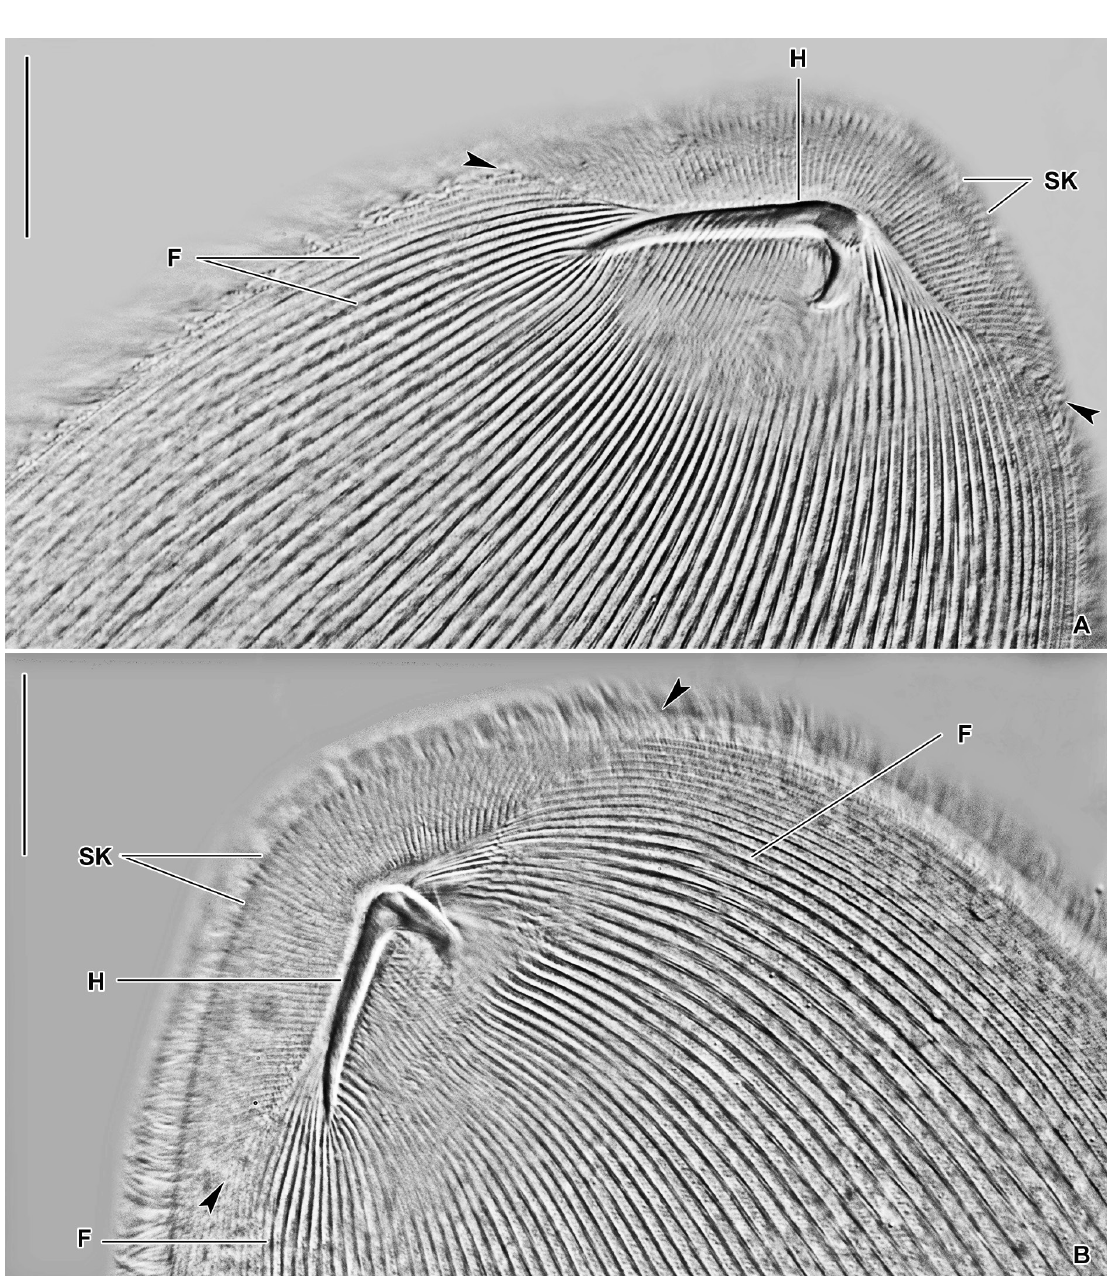
Fig. 5. A–B . Metaradiophrya lumbrici (Dujardin, 1841), Slovak specimens in vivo . Details of the anterior body portion, showing the fibrillar hook and its associated fibers. There are on average 6 (5‒7) fibers attached to the upper right side of the longer arm, on average 33 (30‒37) fibers to the ventral side of the longer arm and on average 11 (8‒13) fibers to the left side of the shorter arm. Arrowheads mark the subapical suture extending from the right body margin over the fibrillar hook towards the left body margin. The somatic kineties above the suture run towards the anterior body end where they curve onto the dorsal body side to meridionally extend over its surface towards the posterior body end. On the other hand, the somatic kineties below the suture run meridionally over the ventral side towards the posterior body end. The ventral somatic kineties are lined with fibers attached to the fibrillar hook. Scale bars: 20